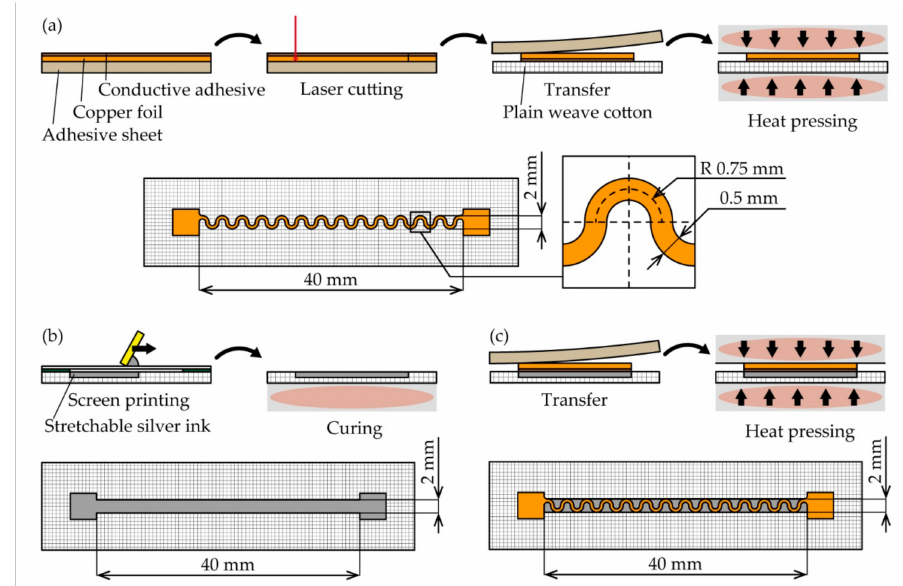
Figure 2. Fabrication processes and dimensions for ( a ) meandering copper (single crack growth); ( b ) silver ink (multiple crack growth); and ( c ) double-layered patterns (a combination of single and multiple crack